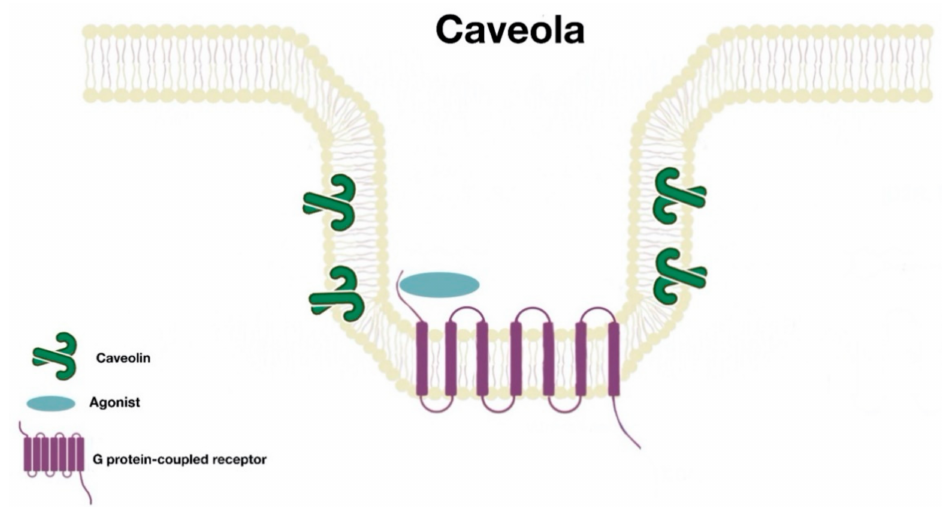
Figure 2. Caveola